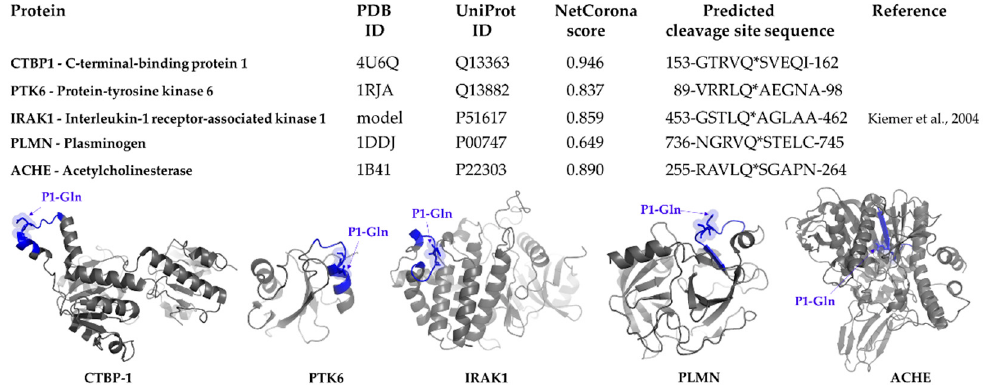
Figure 3. Putative SARS-CoV-2 3CLpro cleavage sites in some selected human target proteins. For the selected proteins, PDB and UniProt identifiers are shown, the scores and cleavage sites predicted by NetCorona 1.0 webserver are also indicated. Predicted score for IRAK1 was reported previously [26]. The structures of the proteins are also shown (grey), the predicted cleavage sites are highlighted (blue), arrows show the P1-Gln residues.